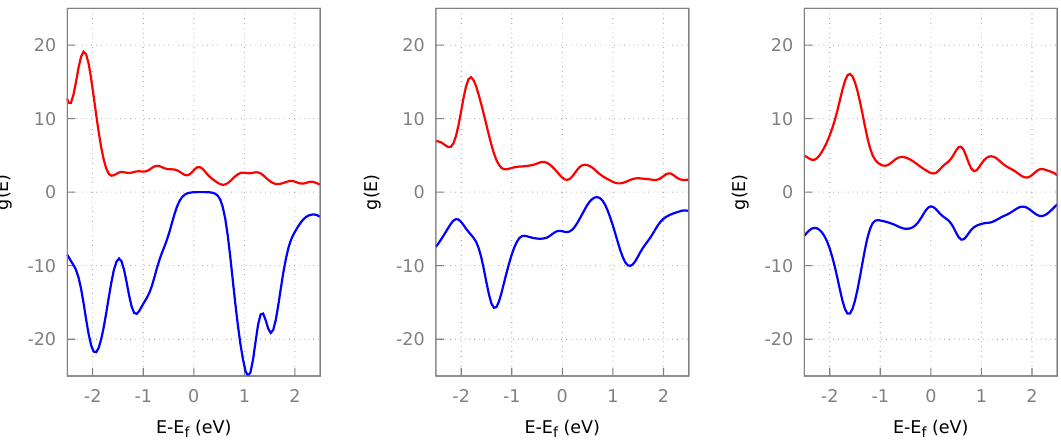
Figure 16. Density of states (DoS) for bulk CFAS ( left ) and two candidate half-Heuslers: F1 ( middle ) and A1 ( right ). The red and blue lines show the DoS for the majority and minority spins respectively relative to the Fermi energy. These are characteristic of the FM and AFM structures discussed in this paper. It can be seen that, unlike bulk CFAS, neither of the half-Heusler structures have a band gap in the minority spin